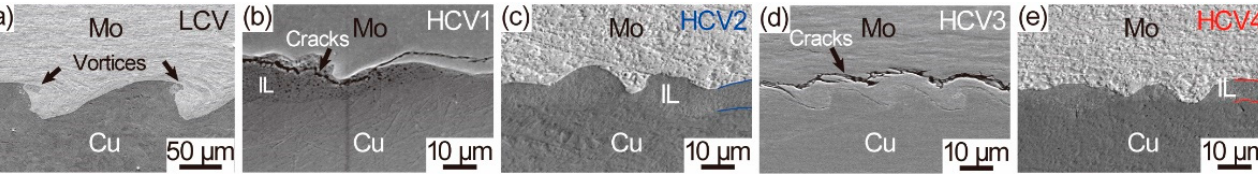
Figure 3. Cross-sectional field emission scanning electron microscope (FE-SEM) images of as-explosive-welded clads produced at ( a ) LCV, ( b ) HCV1, ( c ) HCV2, ( d ) HCV3, and ( e ) HCV4. ( b , c , e ) IL: Intermediate layer.